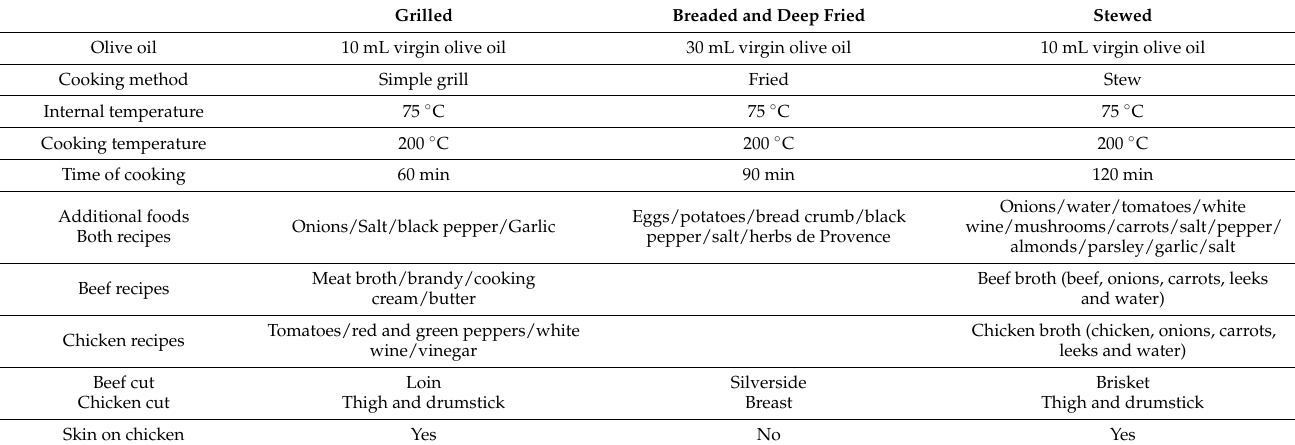
Table 1. Cooking methods characteristics for both beef and